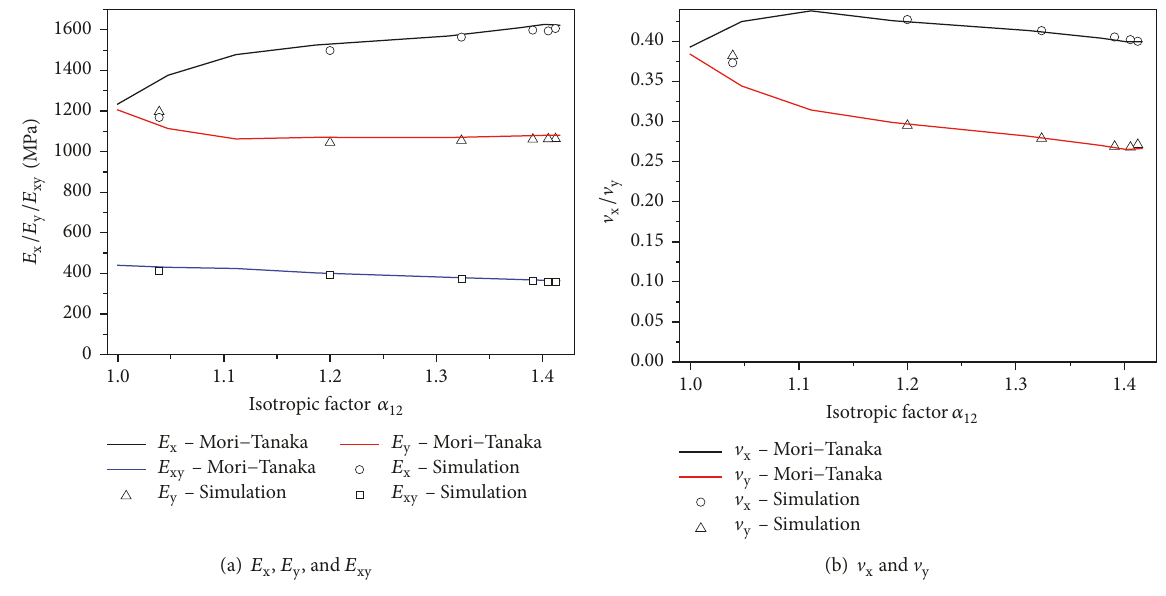
Figure 8: Relationship between elastic constants and isotropic factor 𝛼 12 .